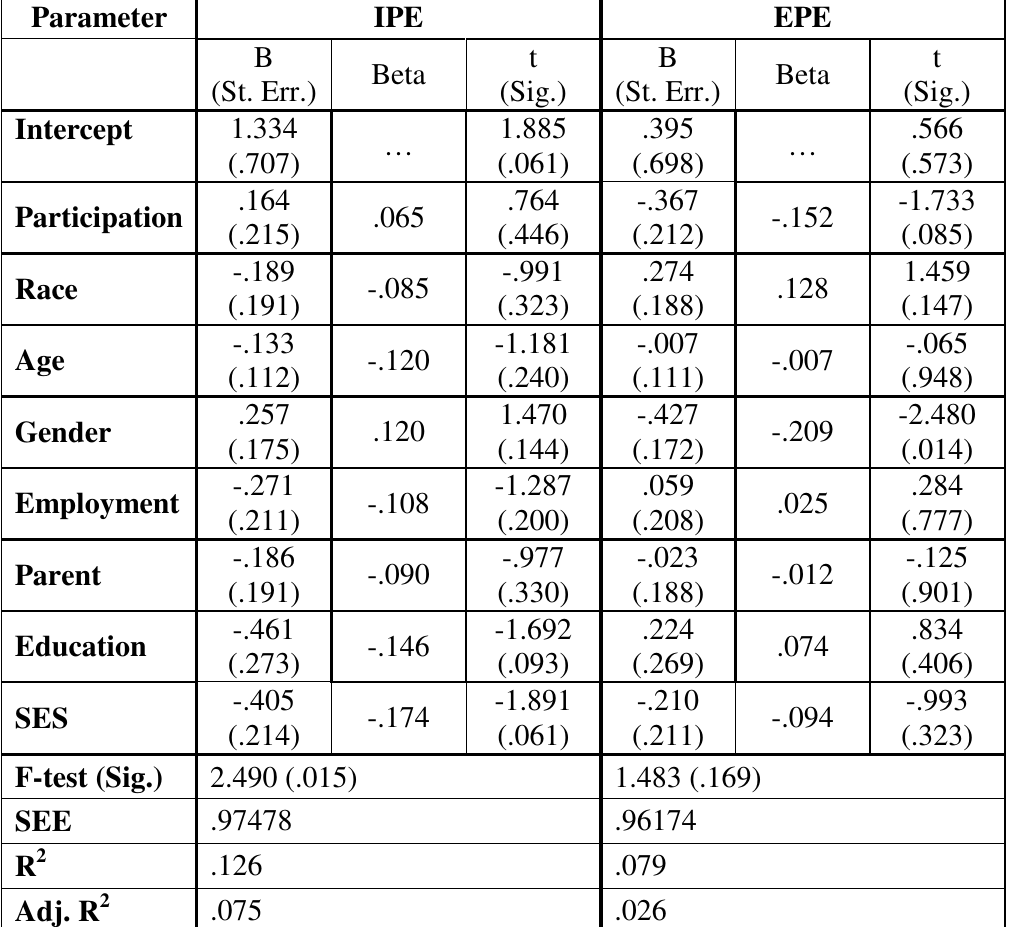
Table 11: OLS Results - IPE and EPE among Participants and Non-Participants at Time 3